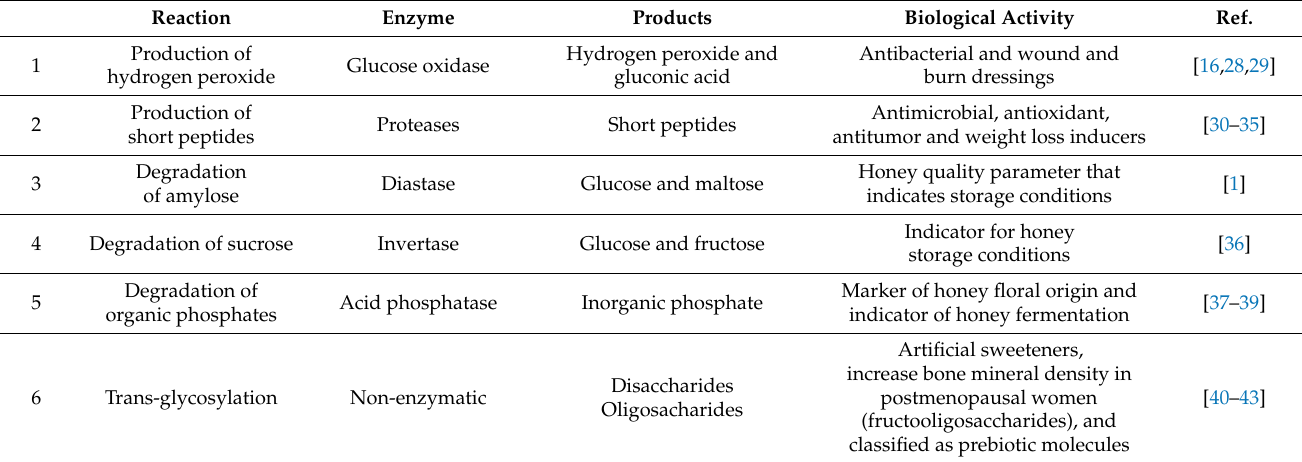
Table 1. Honey reactions and their biological